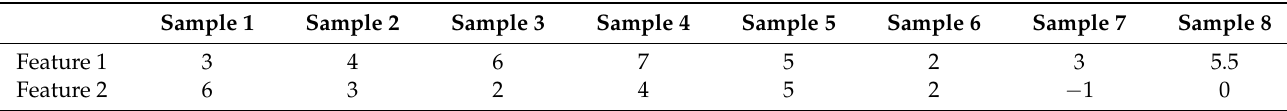
Table 1. The information of the two-dimension feature samples.